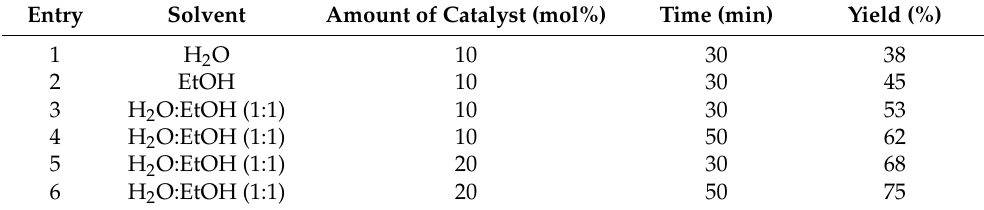
Table 1. Optimization of reaction conditions in the synthesis of pyranopyrazoles.